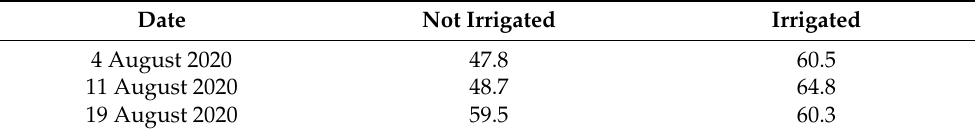
Table 5. The average measured crop height [cm] at four points (irrigated and non-irrigated; soybean) in the field. The crop height for each point represents the average of three other points around the point.